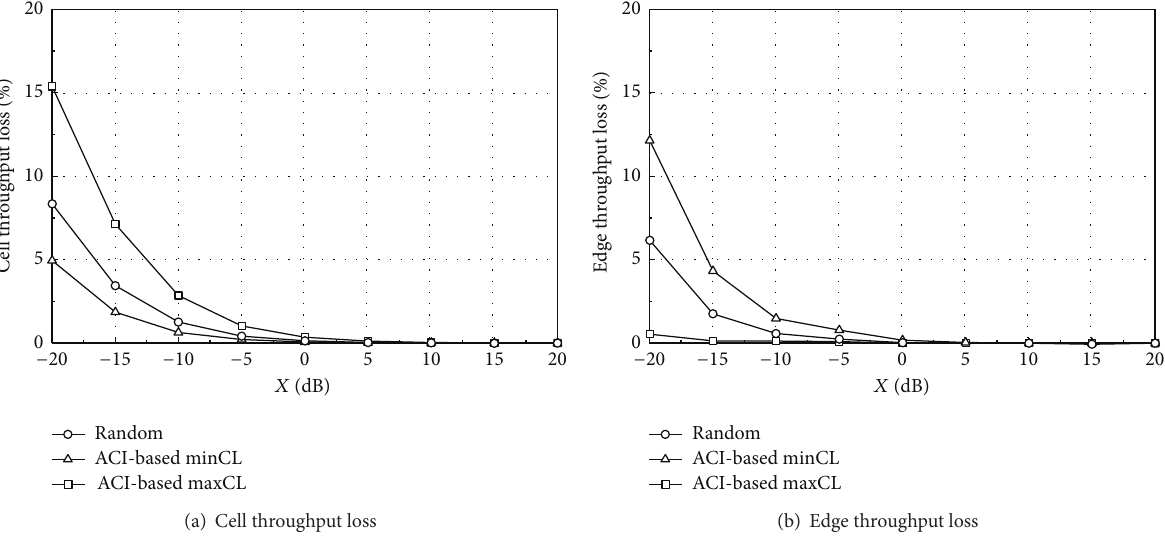
Figure 7: Throughput loss (TPC set 1, coordinated).